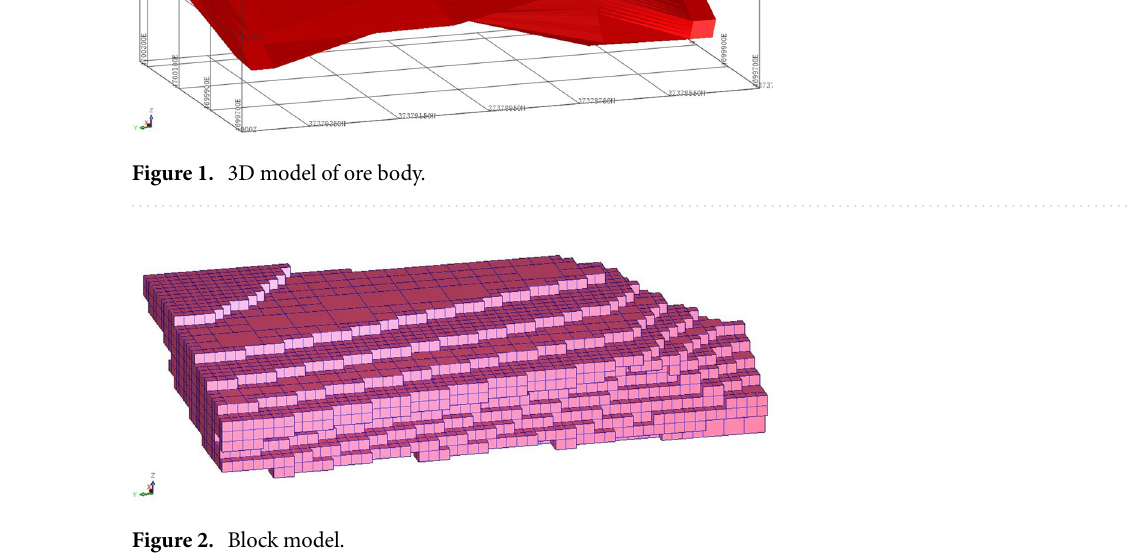
Figure 2. Block model.